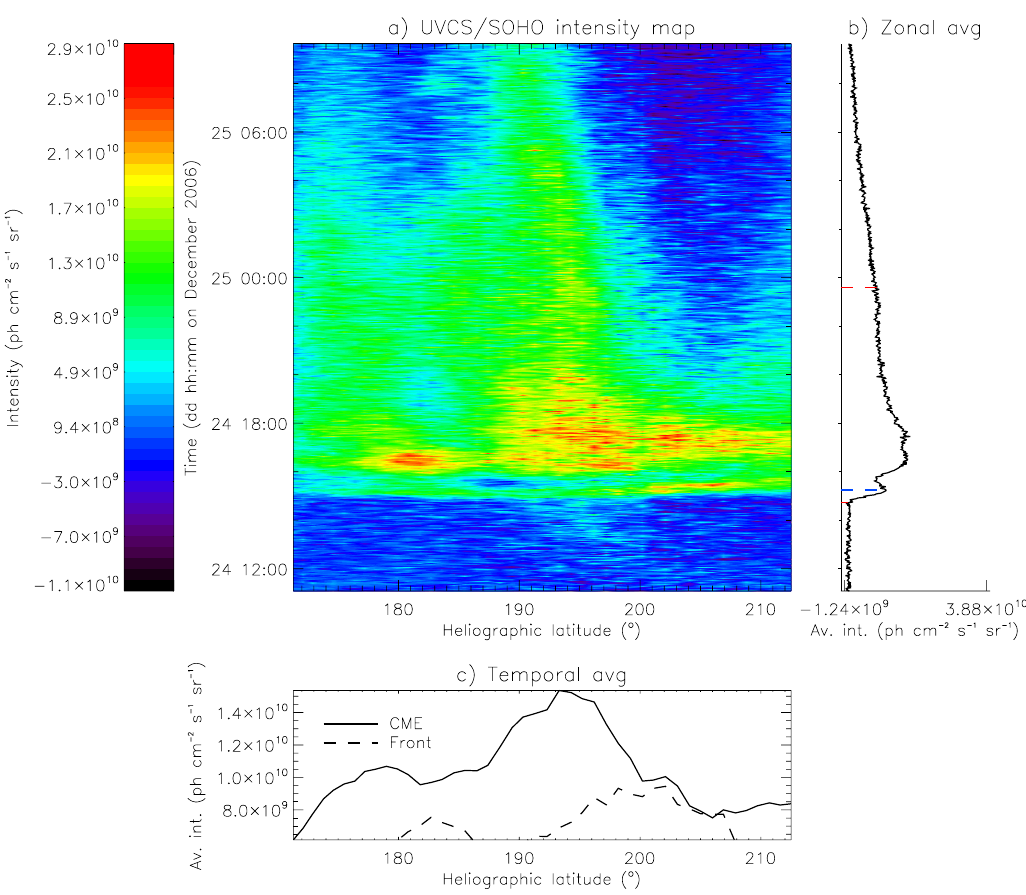
Figure 2. ( a ) Synoptic map of the H I Ly α line intensity as a function of time and heliographic latitude (expressed in degrees counterclockwise from the North pole). ( b ) Zonal average of ( a ), where the duration of the CME and the arrival time of the CME front (15:14 UT) are indicated by red and blue dashed lines, respectively. ( c ) Temporal average of ( a ) within the whole CME event (solid line) and at the CME front, that is from 14:42 UT to 15:30 UT on 24 December 2006 (dashed